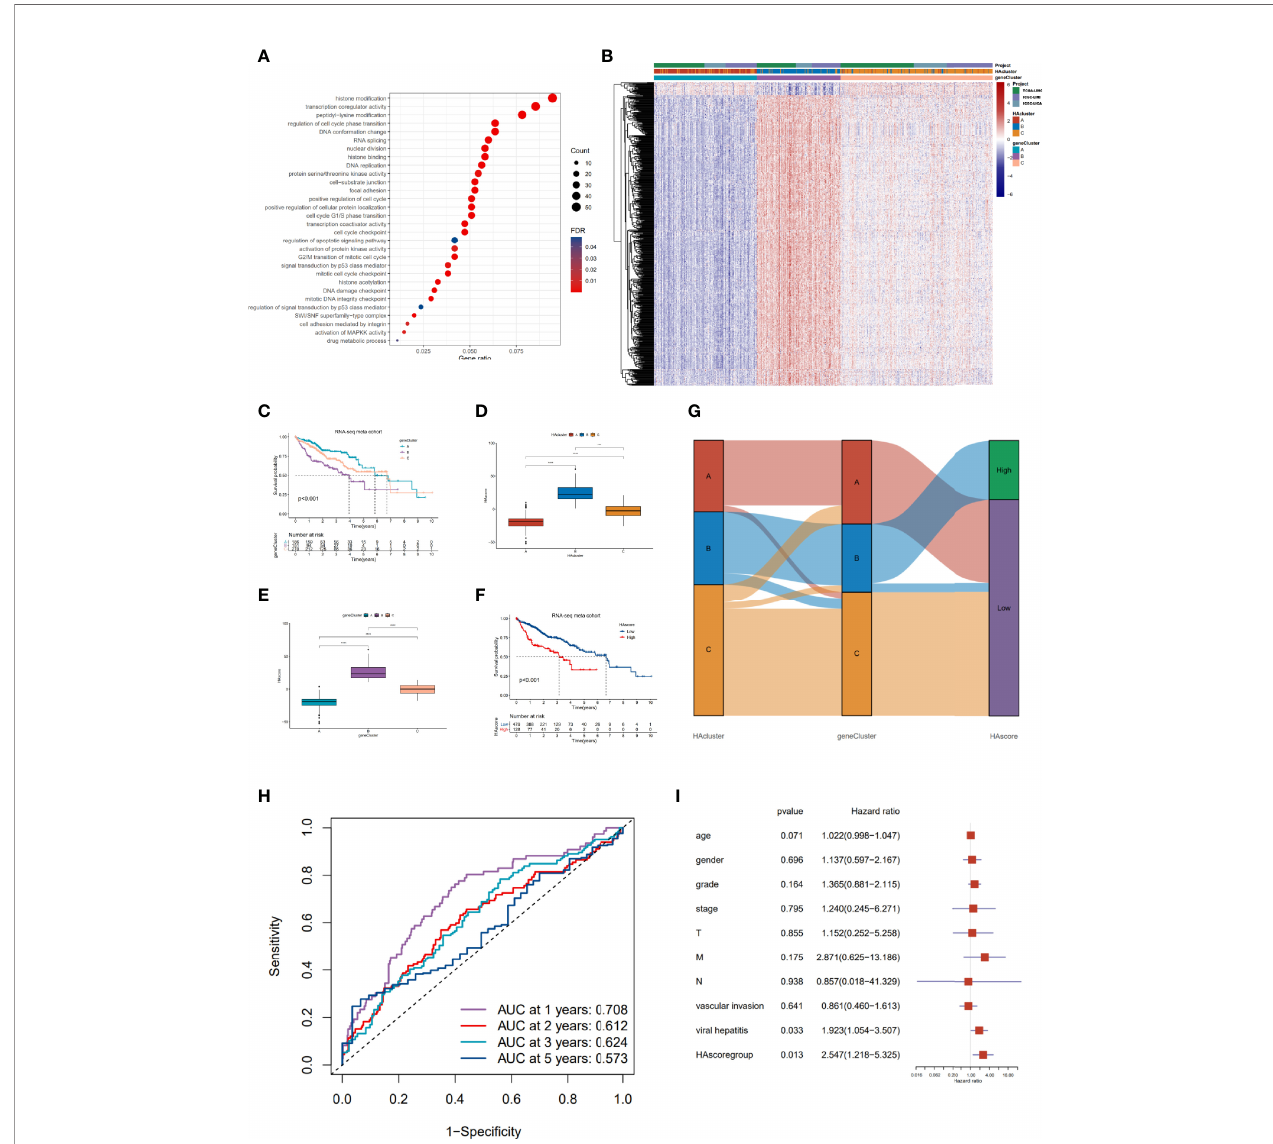
FIGURE 4 | Construction of the characteristic signature of histone acetylation patterns and its prognostic signi fi cance. (A) GO enrichment analysis for histone acetylation pattern related genes with prognostic signi fi cance. The x-axis indicates the gene ratio within each GO term. (B) Unsupervised clustering of 591 histone- acetylation-related genes in RNA-seq meta cohort. The HAcluster, geneCluster, and cohorts were used as sample annotations. (C) The survival curves of different geneClusters in the RNA-seq meta cohorts (TCGA-LIHC and ICGC-LIRI) were estimated by the Kaplan – Meier plotter (p = 1.62e-05, Log-rank test). (D) Differences in the HAscores of the HAclusters in the RNA-seq meta cohorts. (E) Differences in the HAscores of the geneClusters in the RNA-seq meta cohorts. The statistical differences were tested by the Kruskal – Wallis test. (**** P < 0.0001). (F) Survival analyses for low and high HAscore groups in the RNA-seq meta cohort (TCGA-LIHC and ICGC-LIRI) using Kaplan – Meier curves ( P = 4.28e-07, Log-rank test). (G) Alluvial diagram demonstrating the changes in the HAcluster, geneCluster, and HAscore groups. (H) The predictive value of HAscore in patients from the TCGA-LIHC and ICGC-LIRI RNA-seq meta cohorts (AUC: 0.708, 0.612, 0.624 and 0.573 for 1, 2, 3, 5- year overall survival). (I) Multivariate Cox regression model analysis of the factors including HAscore, patient age, gender, TNM status, histology grade, vascular invasion, and viral hepatitis serologies in the TCGA-LIHC